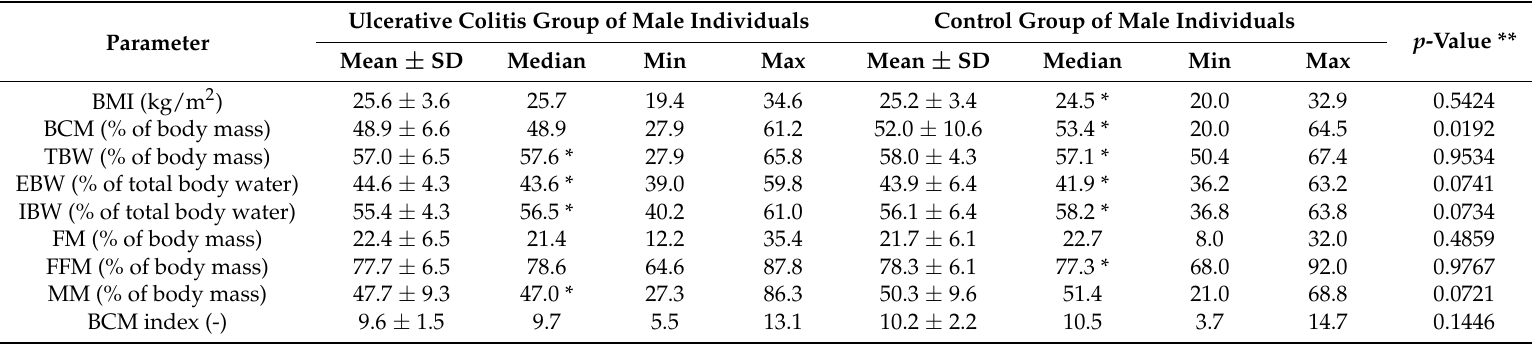
Table 2. The BMI and relative results of body composition measured using bioimpedance method for ulcerative colitis and control groups of male individuals.